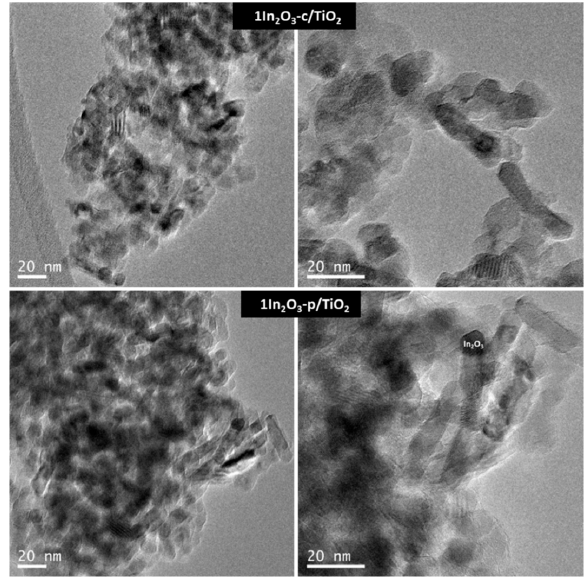
Figure 2. TEM micrographs of 1In 2 O 3 -c/TiO 2 and 1In 2 O 3 -p/TiO 2 catalysts. UV/Vis diffuse reflectance spectra (Figure 3) show that, in both c- and p-series, the presence of indium oxide led to increased absorption in the visible range, which increased